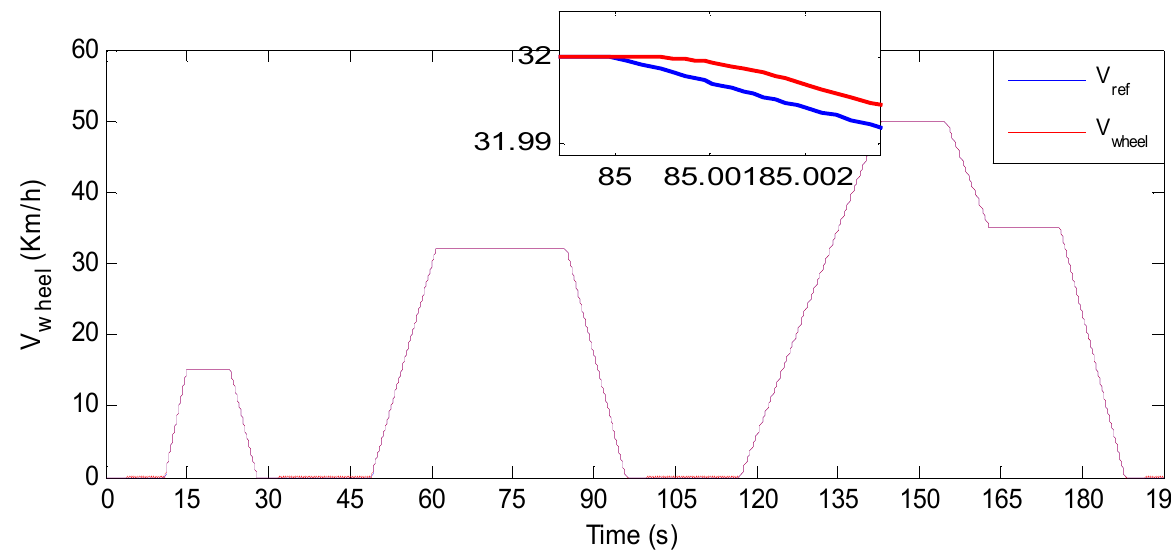
Figure 25. BEV speed response and its reference for ECE driving cycle.